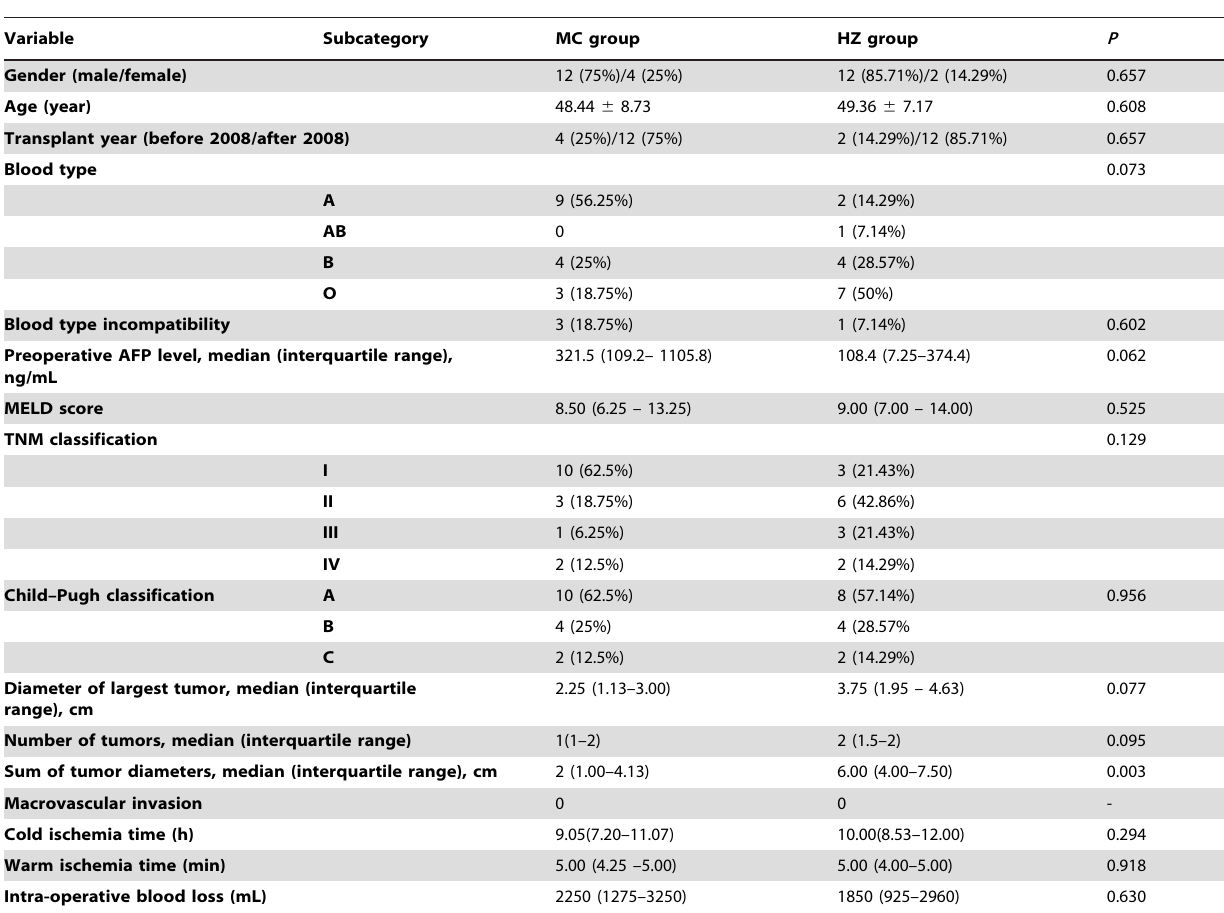
Table 2. Clinical characteristics of patients in the MC group and HZ